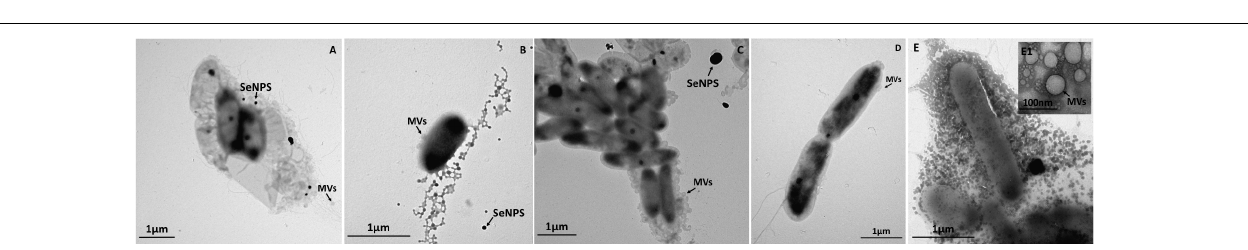
FIGURE 3 | Time course imaging by TEM of Stenotrophomonas maltophilia SeITE02 strain grown in DM amended with pyruvate (0.5% v/v) and SeO 2 − 3 (0.5 mM) for 24-h (A) , 48-h (B) , 72-h (C) , 96-h (D) , and 120-h (E) . The inlet (E1) shows an enlargement of microbial vesicles (MVs), which is indicated by black arrow, as well as